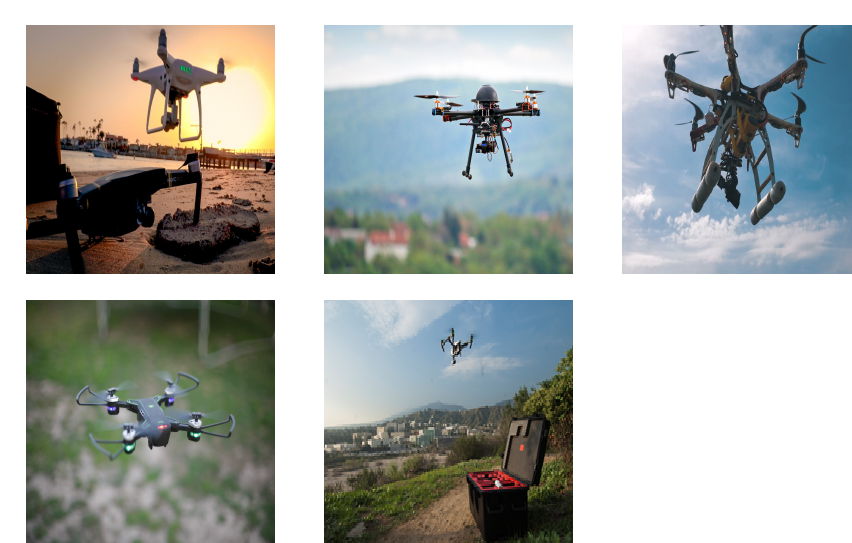
Figure 3. Sample images from the drone